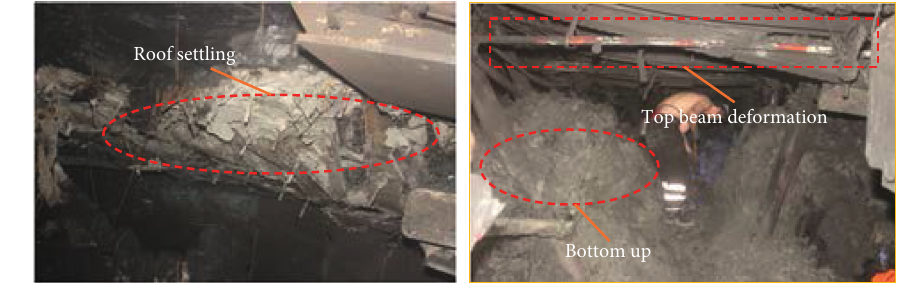
Figure 2: Deformation of two roadways in the working face